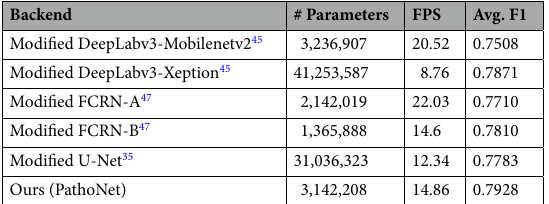
Backend # Parameters FPS Avg.